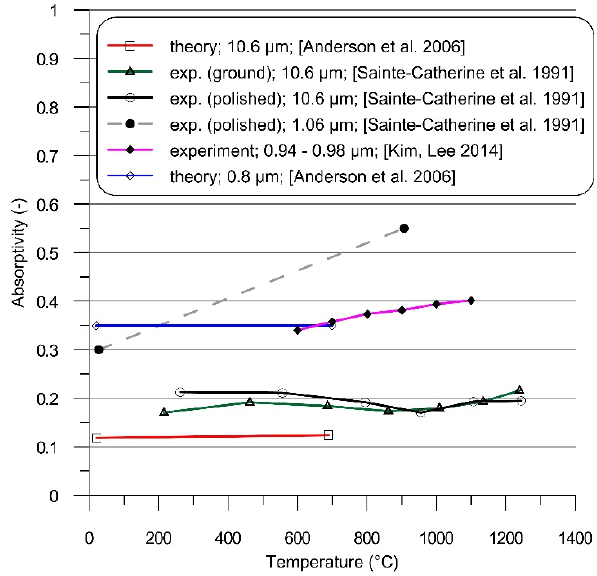
Figure 6. Normal spectral absorptivity of Inconel 718.